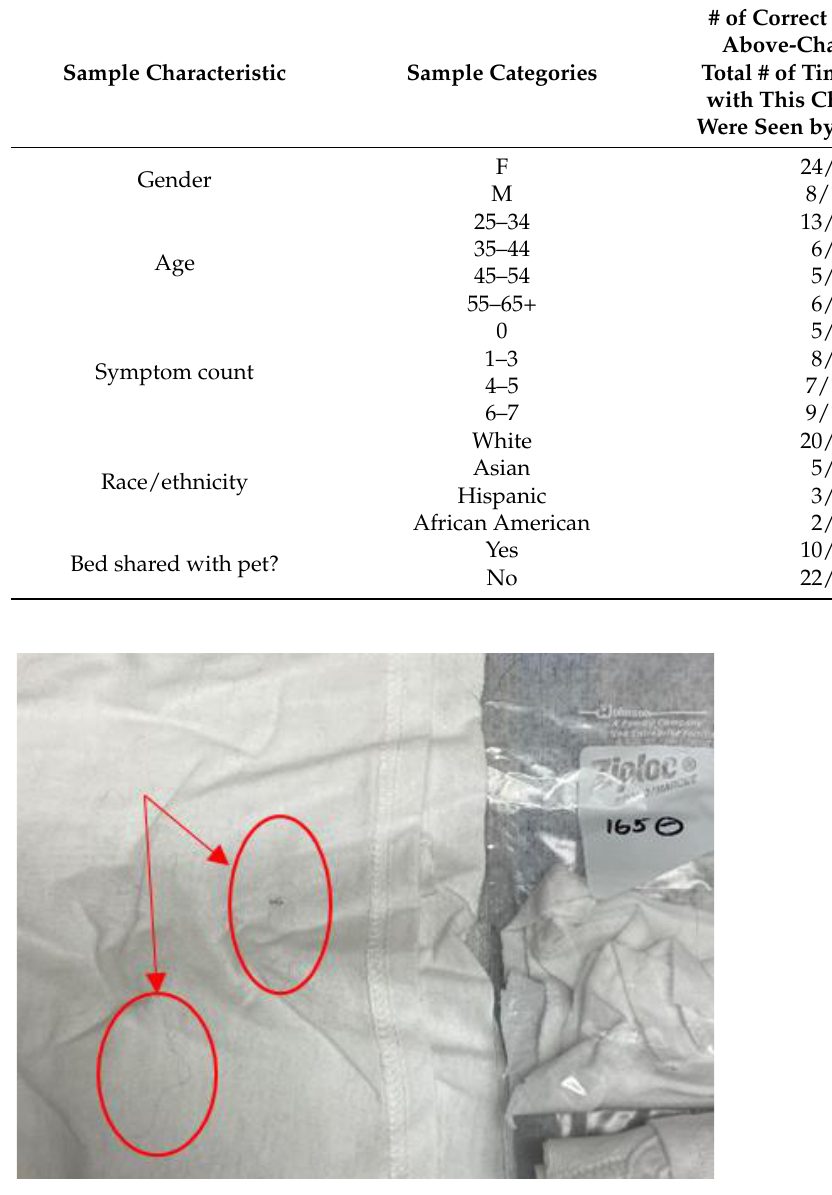
This table shows the samples used in the canine tests and the elapsed time between